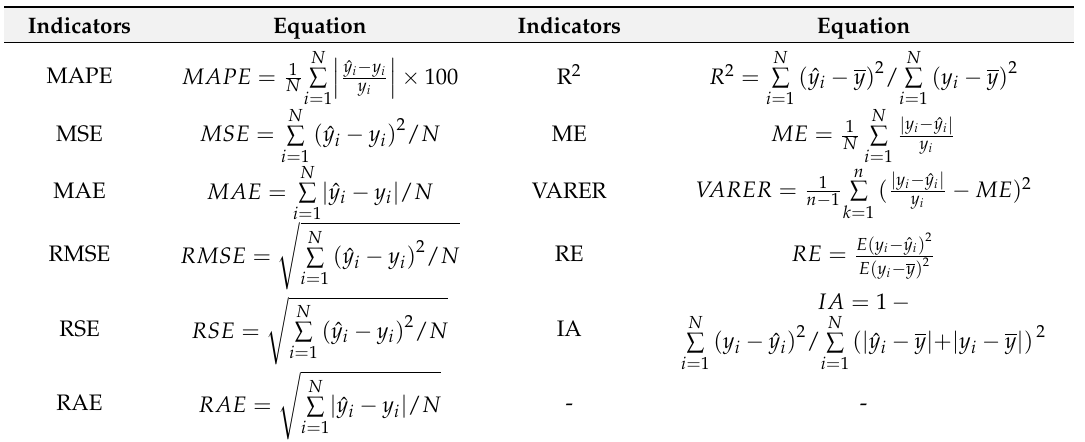
Table 3. The performance indicators for the prediction function [23].